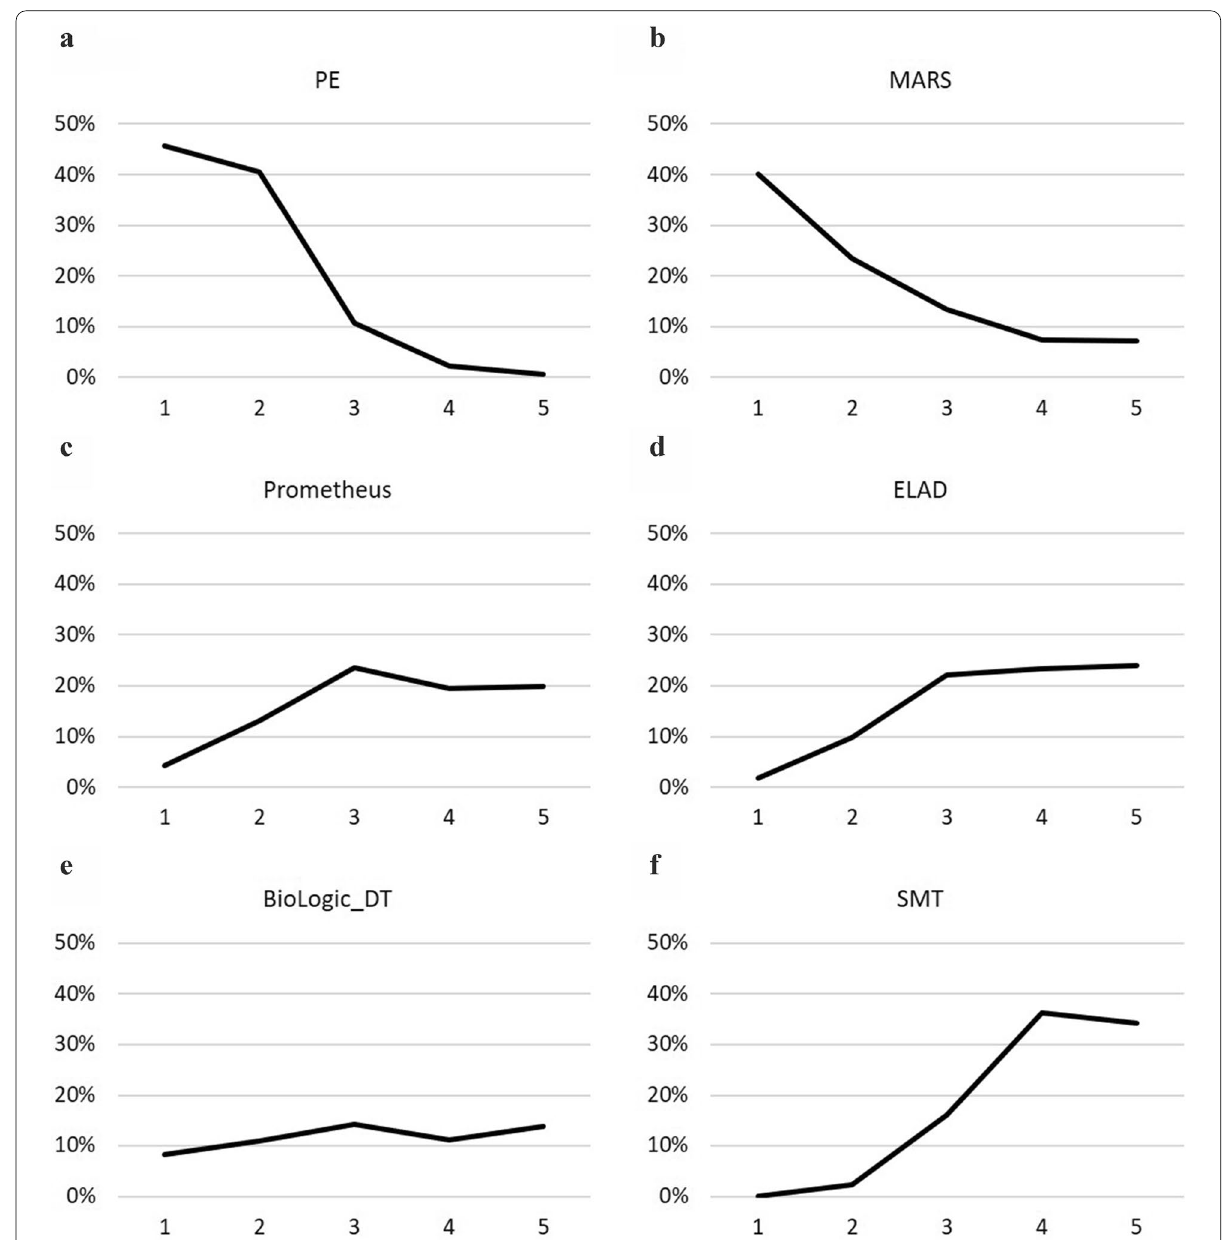
Fig. 3 Rankograms for 3-month overall survival: Rankograms show the probability (x axis) of the respective treatment achieving certain ranks (y axis). a Plasma exchange, b molecular adsorbent and recirculating system, c Prometheus, d extracorporeal liver assist device, e BioLogic-DT, f Standard medical